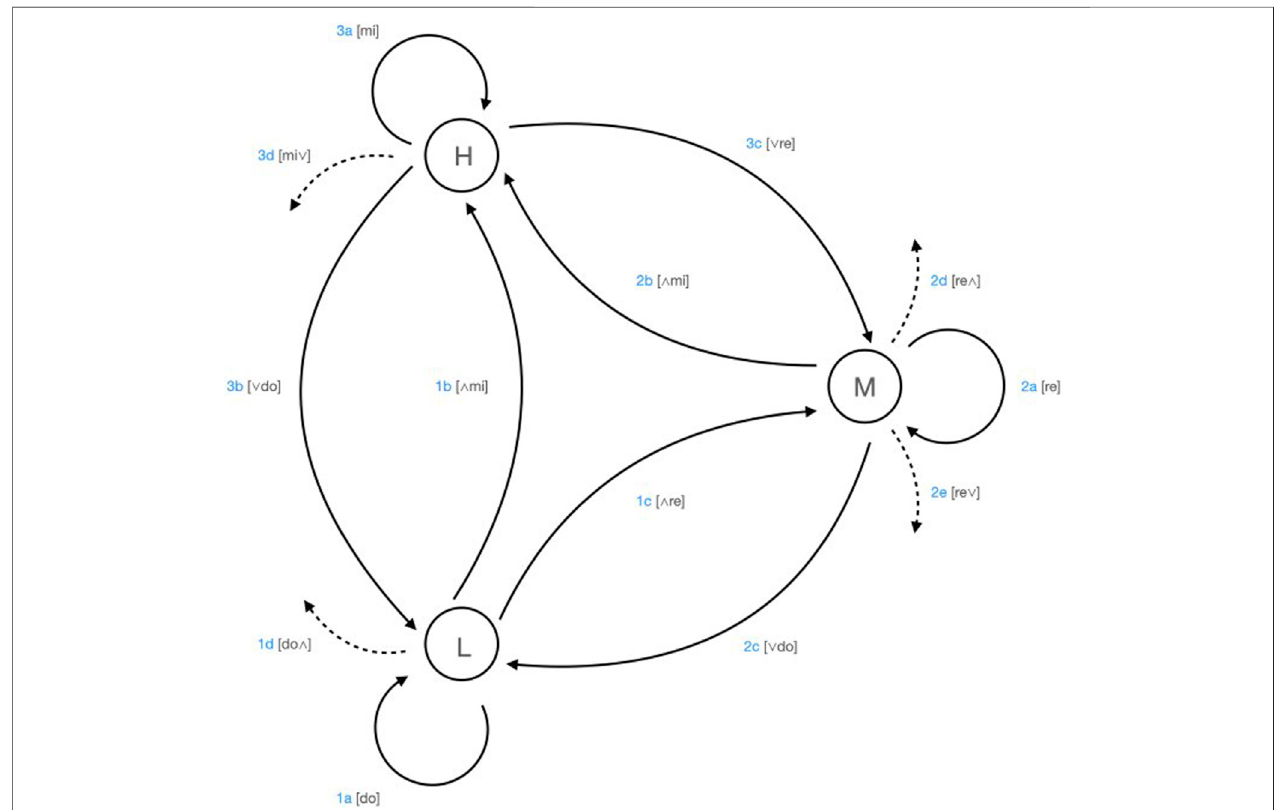
FIGURE 2 | Graphic representation of the dùndún speech surrogacy system as a fi nite state machine.